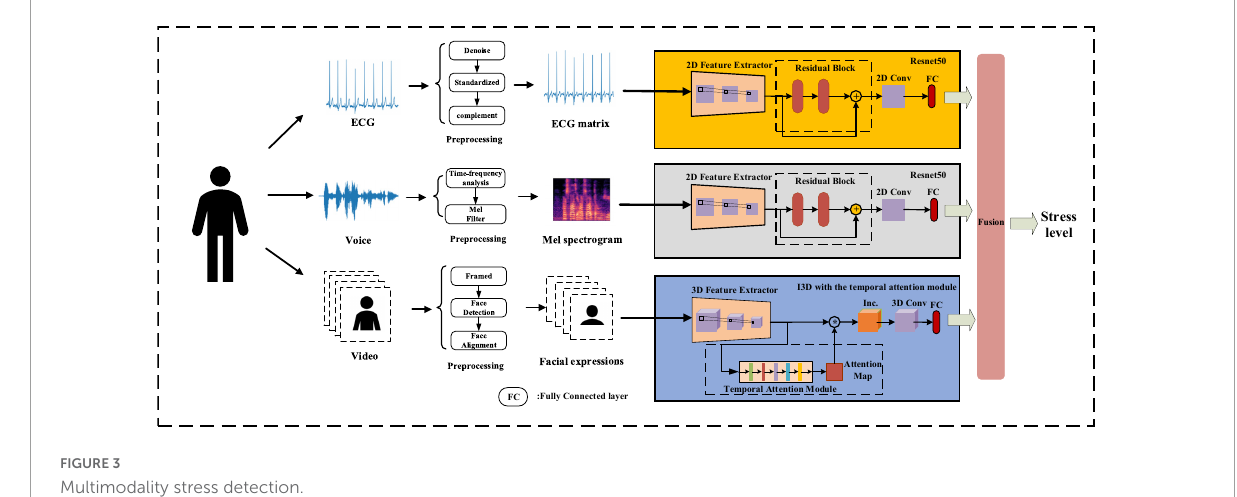
FIGURE3 Multimodality stress detection.